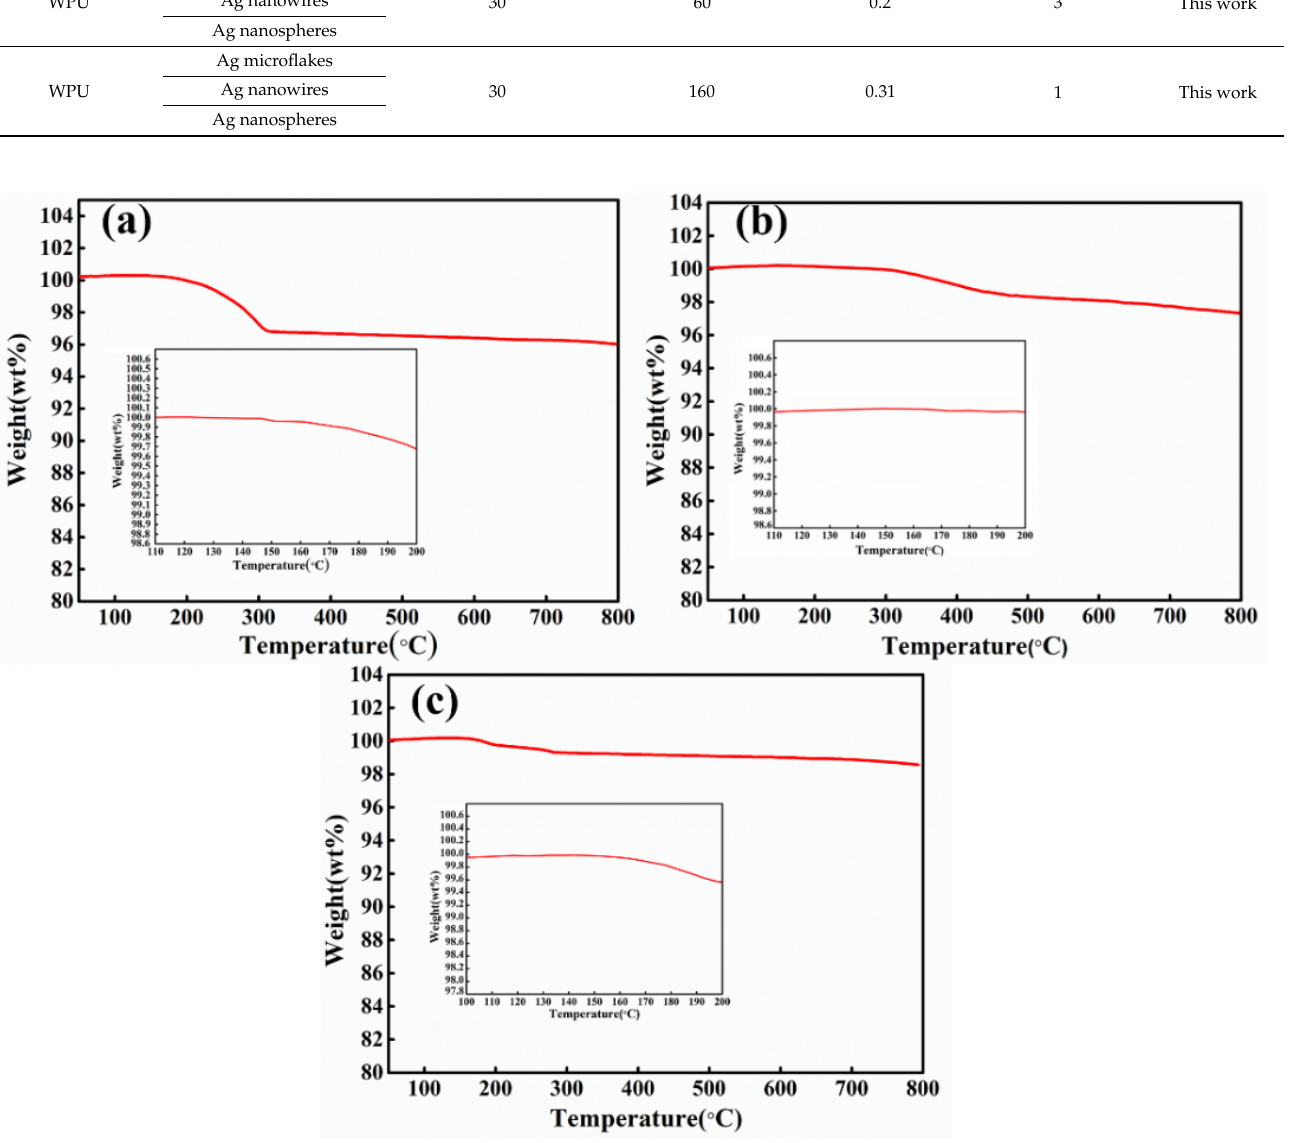
Figure 9. TG curves of ( a ) Ag NPs without other heat treatment, ( b ) Ag NWs without other heat treatment and ( c ) Ag MFs without other heat treatment. The insets show a magnified TG curve in the range of 110–200 °C for Ag NPs, in the range of 110–200 °C for Ag NWs, and in the range of 100–200 °C for Ag MFs, respectively.